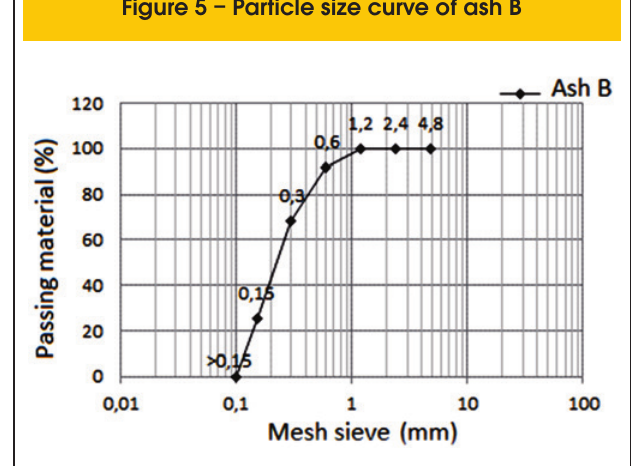
Figure 5 – Particle size curve of ash B